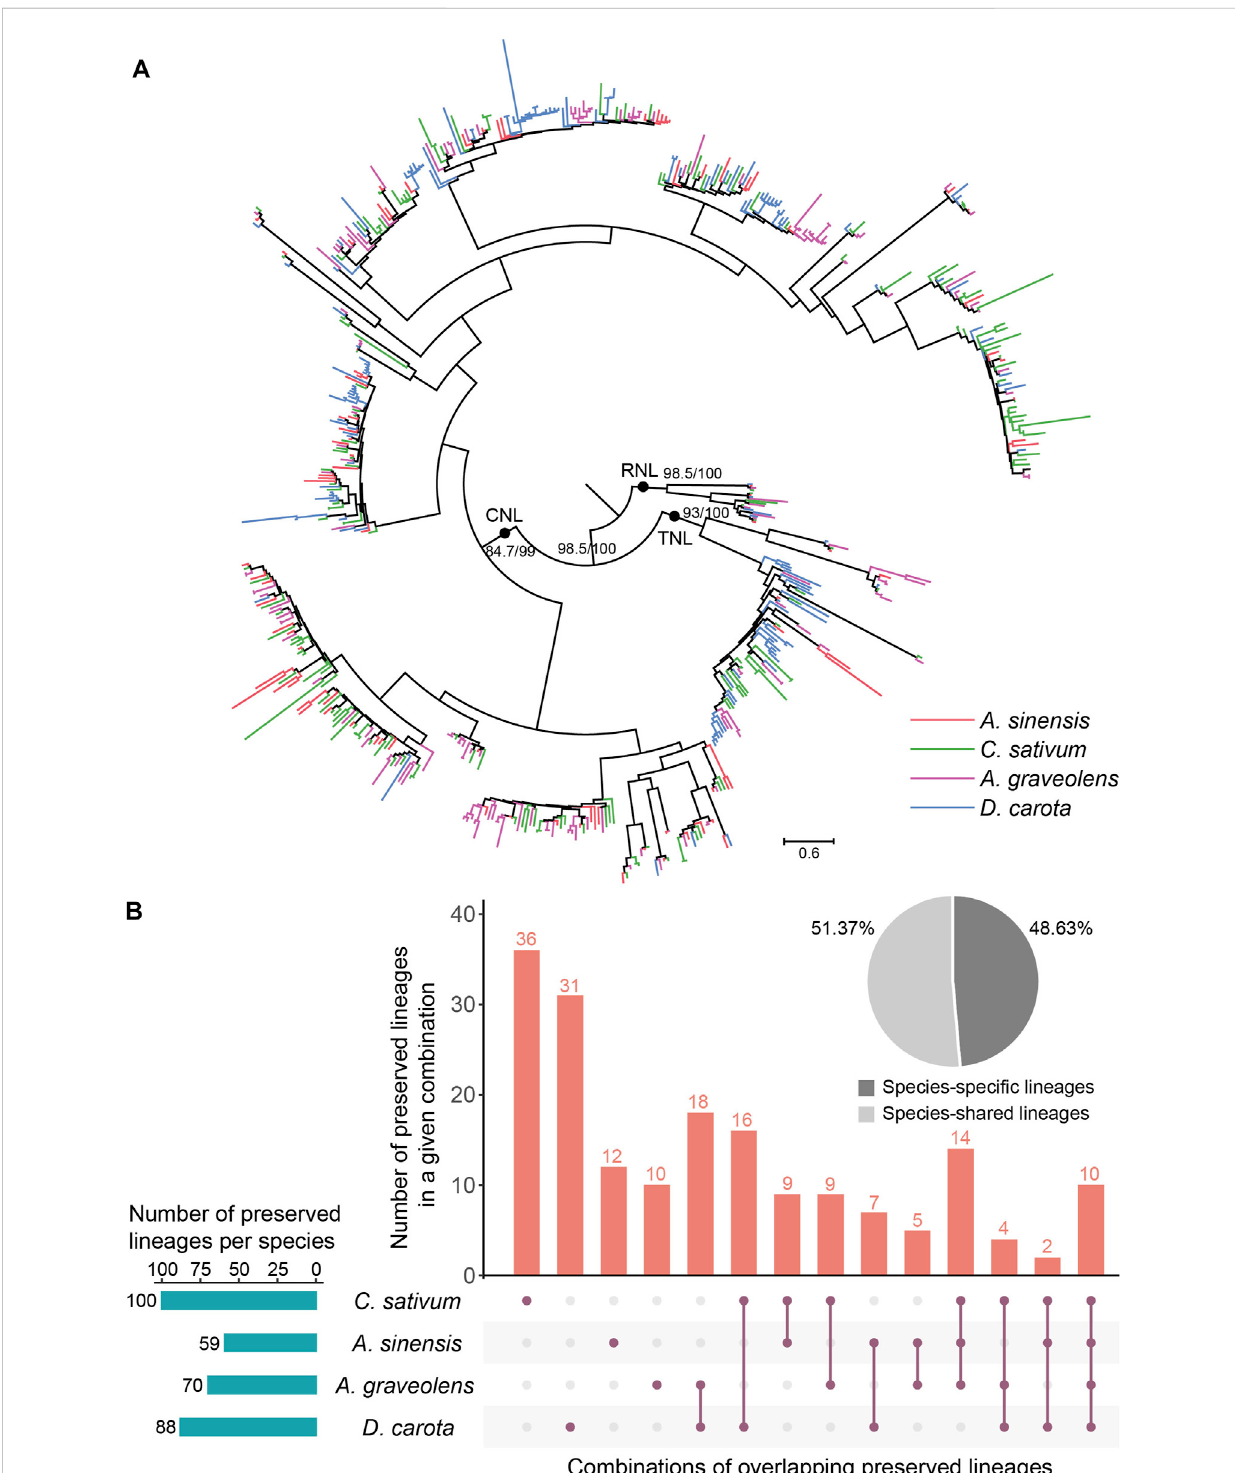
FIGURE 4 Phylogenetic and evolutionary analysis of NLR genes in four Apiaceae species. (A) The phylogeny was reconstructed based on the conserved NBS domain of NLR genes in the four Apiaceae species. Branch support values are obtained using SH-aLRT (%) and UFBoot2 (%), and are labeled on basal nodes. The scale bar represents 0.6 substitutions per site. (B) Specie-shared and species-speci fi c lineages were derived from the 183 ancestral NLR lineages. The total number of preserved lineages per species were shown. The combination, A. sinensis , A. graveolens and Daucus carota , was not displayed due to the lack of the situation that no lineages were found to be preserved in A. sinensis , A. graveolens and Daucus carota , and only lost in C. sativum